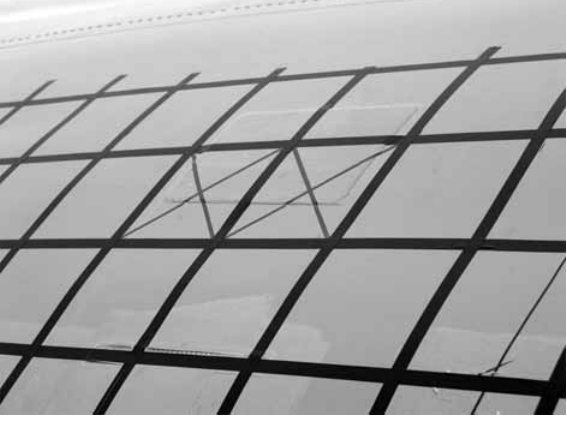
Fig. 22. Outside view of fuselage section before thick shield test.